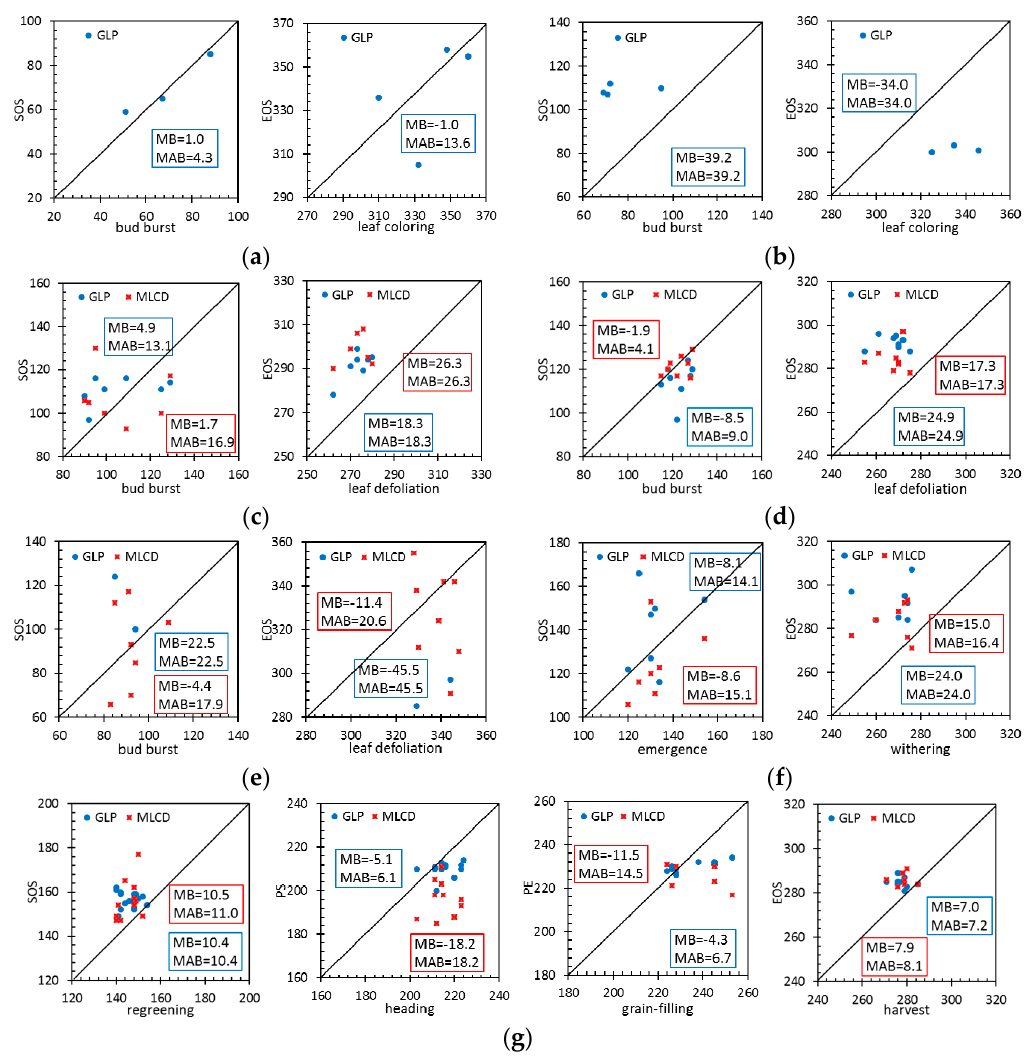
Figure 10. Comparison between the GLP and the MLCD for different vegetation types based on the ground observations. ( a ) HS (ENF); ( b ) DHS (EBF); ( c ) BJF (DNF); ( d ) CBS (DBF); ( e ) SPT (Shrub); ( f ) NM (Grass); ( g ) SY + JT (rice). Table 2. One-to-one correspondence between remote-sensing phenological metrics and phenophases observed from ground observation s.